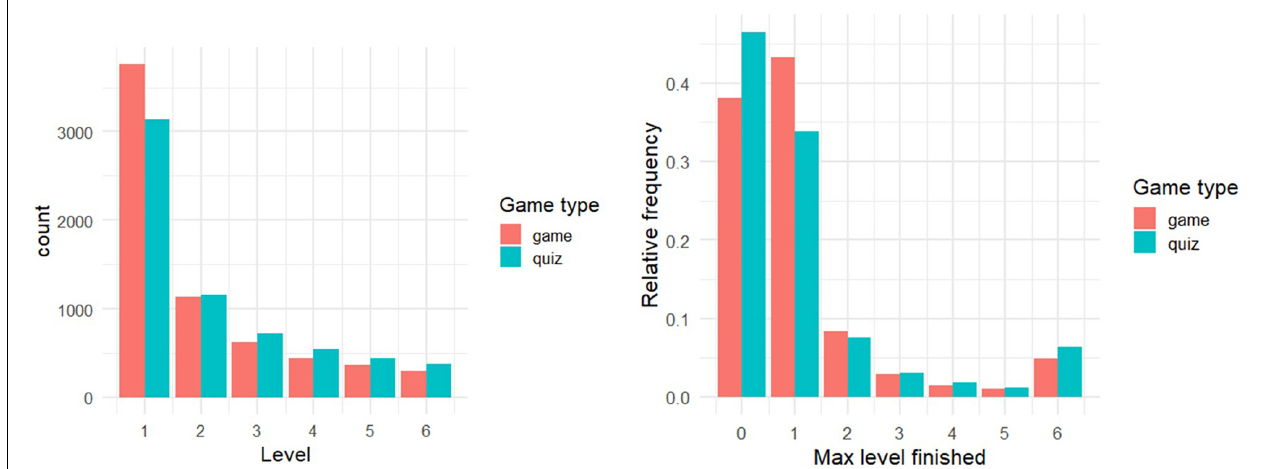
FIGURE 2 | (Left) Number of players who completed either successfully or unsuccessfully x th level. I.e., all players in level x + 1 are also included in level x : the difference between levels x + 1 and x is the dropout rate between those two levels. Apparently, starting from level 2, more participants played the quiz. (Right) Relative percentage of players’ maximum level reached (out of players from each condition). That is, these players played the respective level at least once but might not necessarily have passed it successfully. The higher peak at level 6 corresponds to players who were determined to finish the game. Value 0 denotes players who did not finish even a single round.